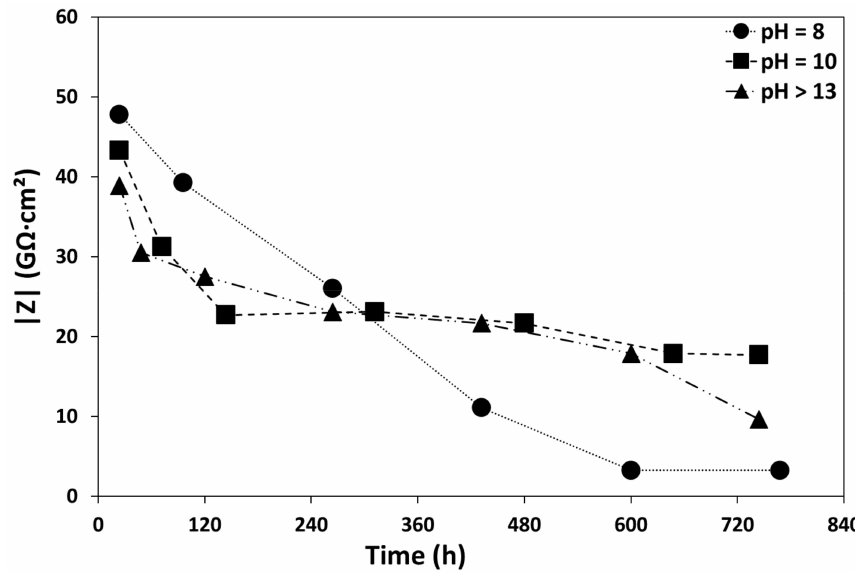
Figure 8. Monitoring of impedance modulus at 0.1 Hz in 1% NaCl for painted HDG steel as a function of the time of exposure and the pH of the alkaline solution (neutral cleaner (pH = 8), mild alkaline cleaner (pH ≈ 10) and strong alkaline cleaner (pH >